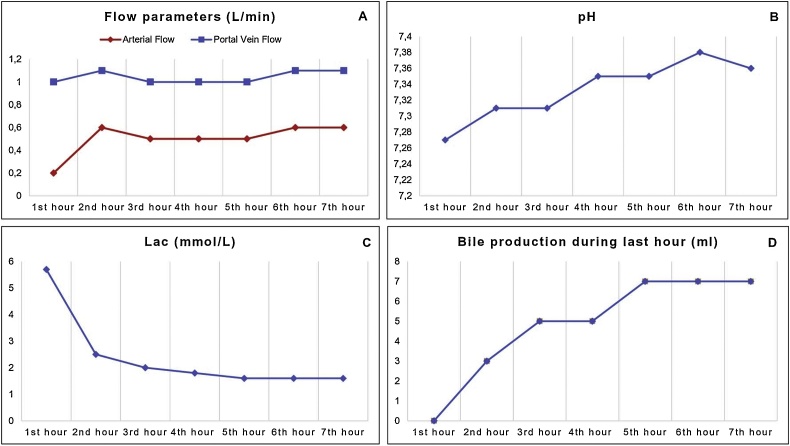
Liver functions parameters during normothermic machine perfusion: (A) Hepatic artery and portal vein flow rate; (B) pH; (C) lactate clearance; (D) bile production.